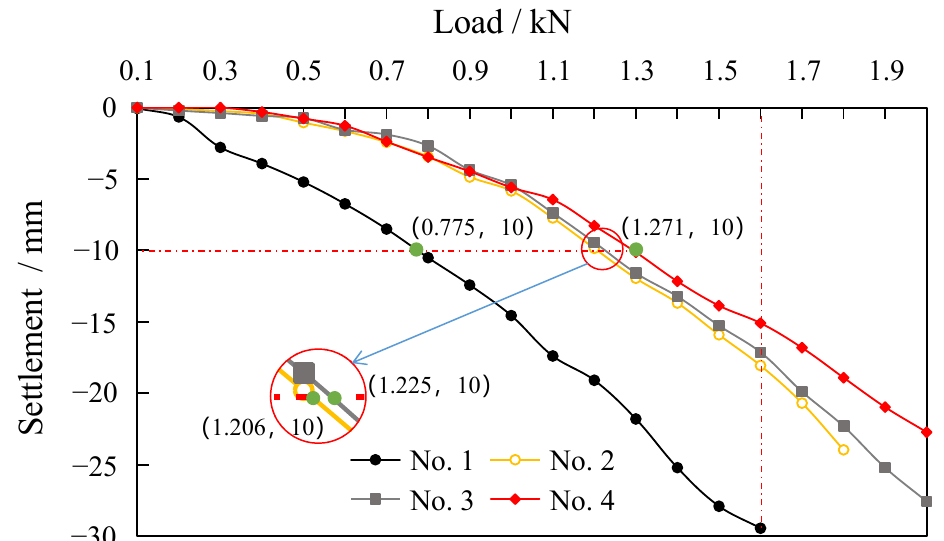
Figure 16. Load–displacement